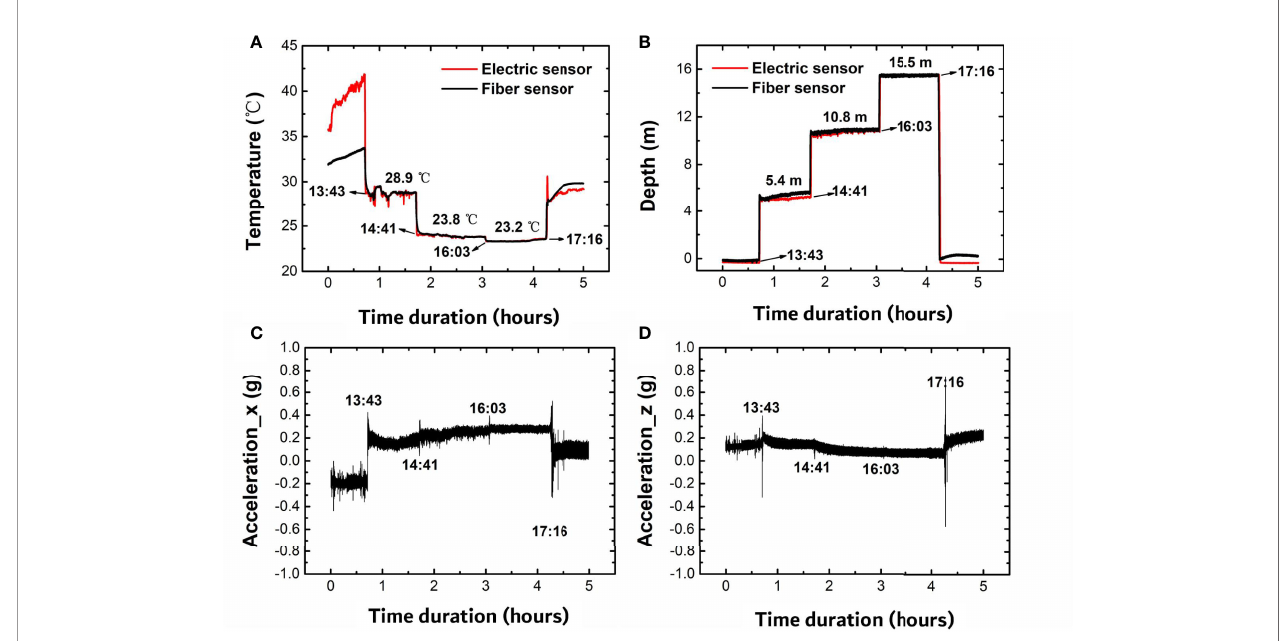
FIGURE 6 | Measured results of the (A) temperature, (B) depth, and (C, D) acceleration by the submarine optical fi ber sensing system under the